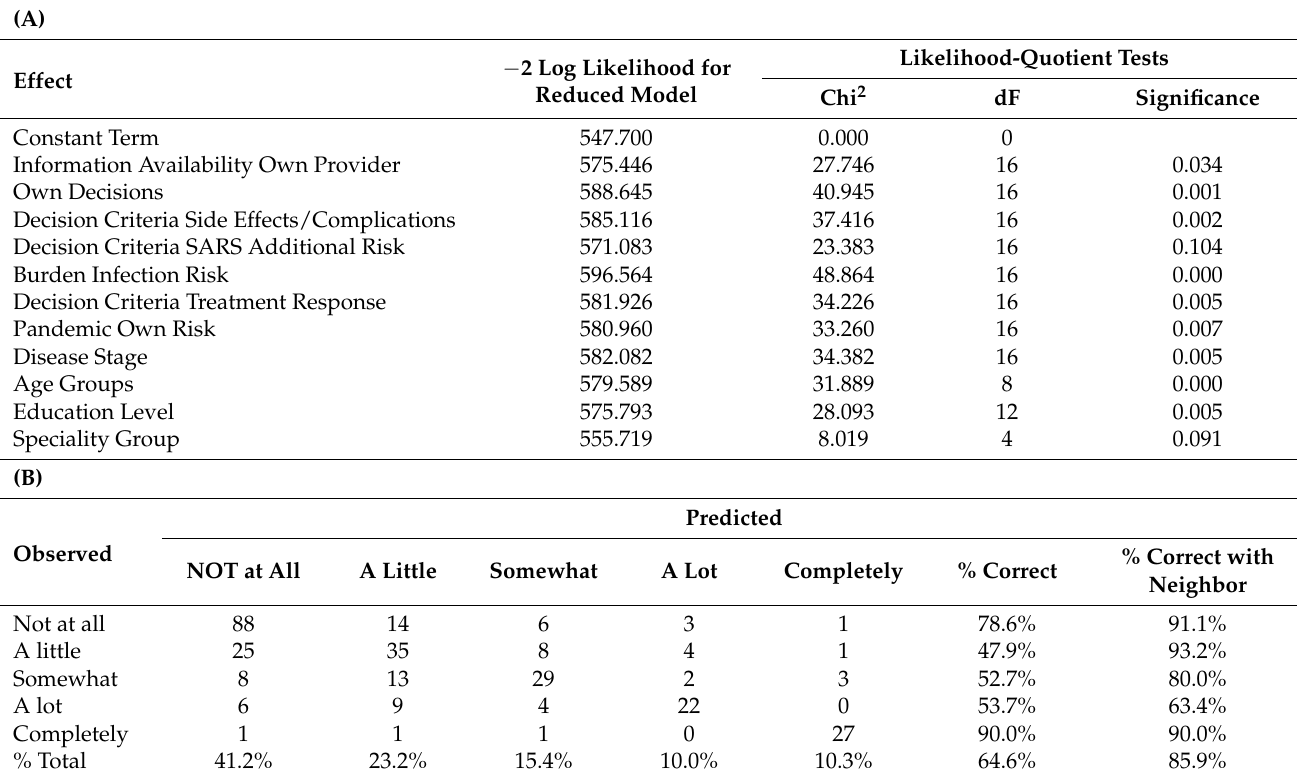
Table 2. Prediction by nominal regression analysis of “Decisional Conflicts” (A) Likelihood-Quotient Test for regression parameters; and (B) resulting